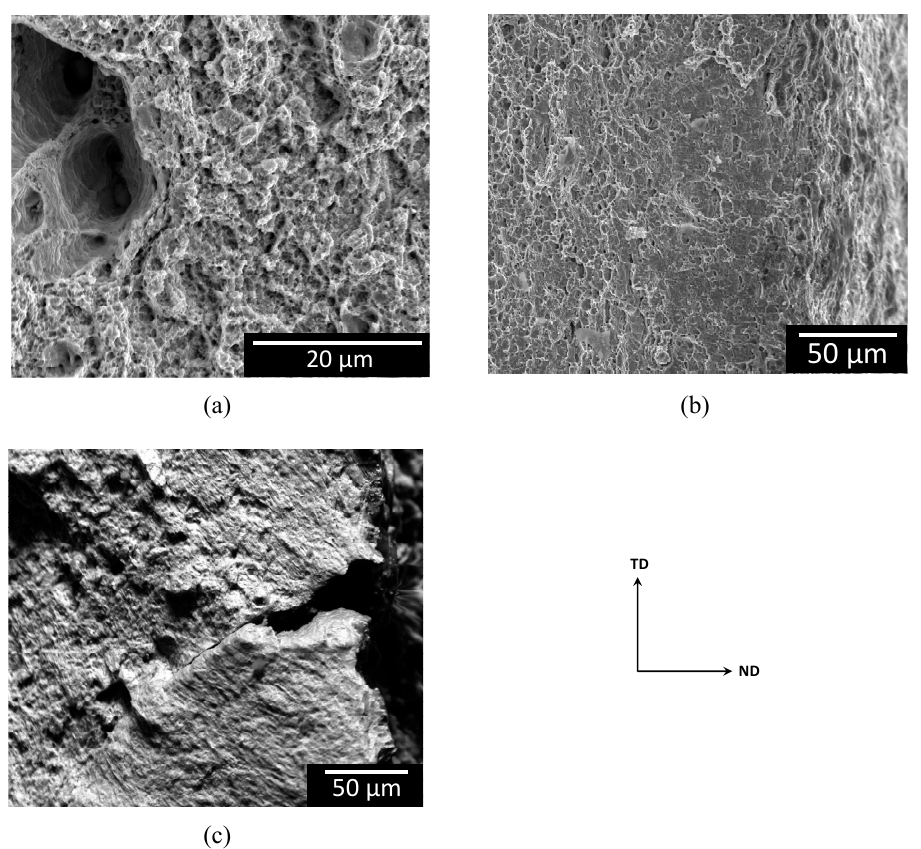
Figure 7. Influence of FFA coating on mechanical properties of NiCrMoV steel in 0.01 M acetic acid at 90 °C ( ε(cid:4662) = 10 (cid:2879)(cid:2874) s (cid:2879)(cid:2869) ).